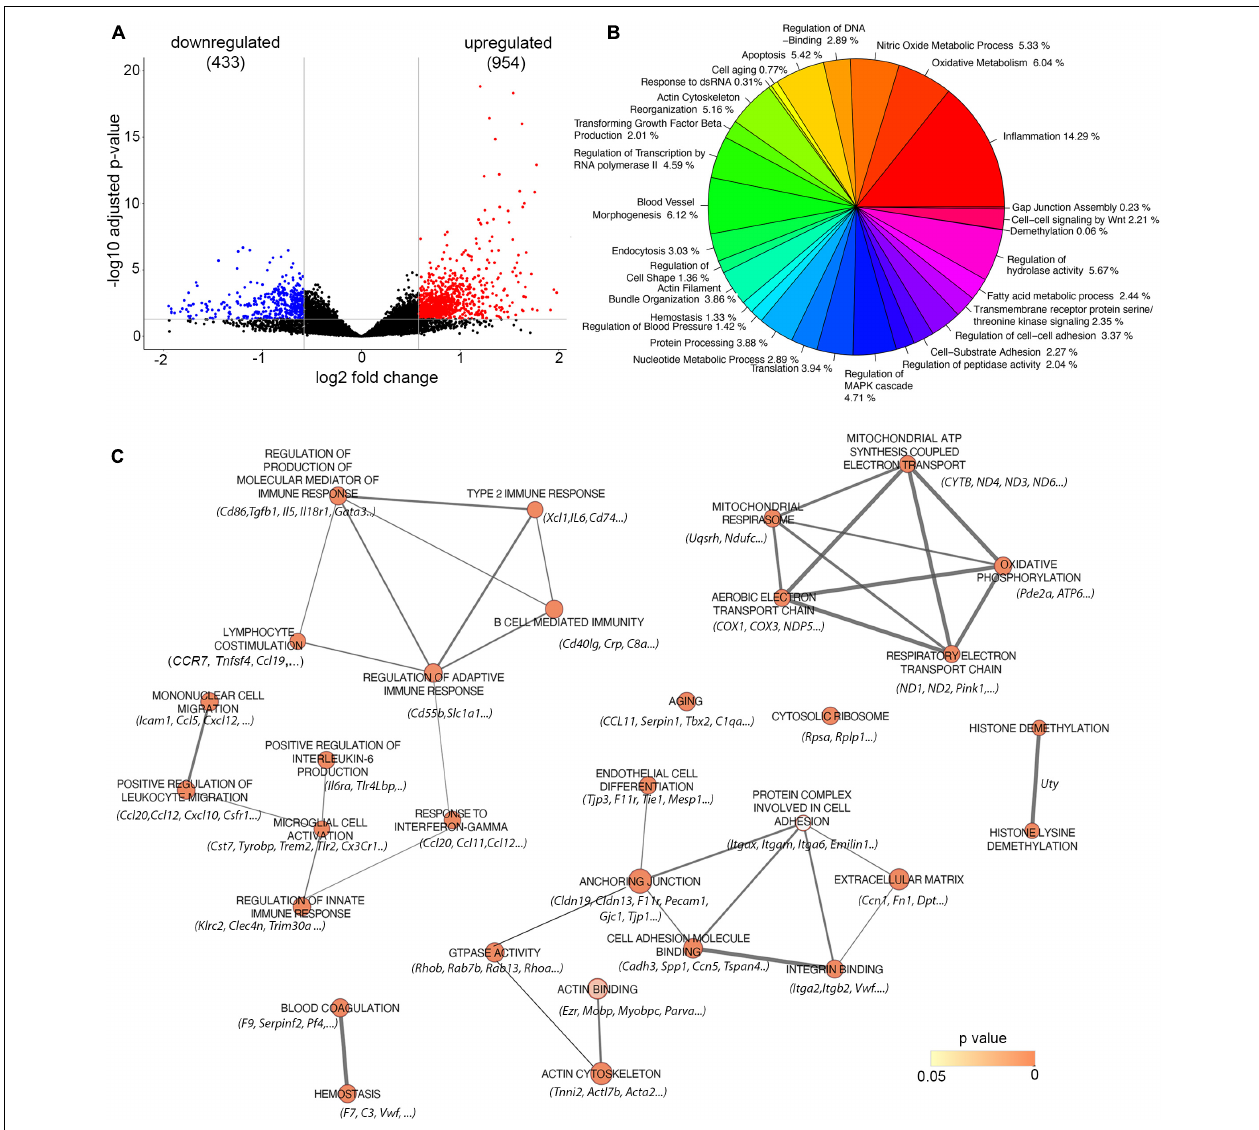
FIGURE 3 | Analysis of Gene expression in isolated microvessels of Tg-SwDI (18 months) and control (18 months). (A) Volcano plot represents differential expressed genes (DEGs). The x and y axes show log2 fold change and − log10 p -value, respectively. Red points are up-regulated genes, blue points are down-regulated genes, and black points are genes with no significant difference. (B) Distinct transcriptomic profiles of 18 months old Tg-SwDI mice with fully developed CAA pathology. Pie chart represents a summarized gene ontology (GO) enrichment analysis of all three categories: biological processes, molecular function, and cellular compartment of differentially regulated genes. Only GO terms enriched with a p < 0.05 were selected and summarized (see methods). (C) Enrichment Map visualization of the top 30 ranked GSEA results obtained from analysis between Tg-SwDI (18 months) and control (18 months). Nodes represent enriched GO terms, and edges represent overlapping relations between GO terms. Nodes are colored and color intensity is proportional to p -value significance. Since conservative thresholds were used to select gene-sets, most of the node colors are intense (corresponding to highly significant gene-sets). The thickness of edges represents the richness of shared genes between connected nodes between each gene sets. Top listed genes are